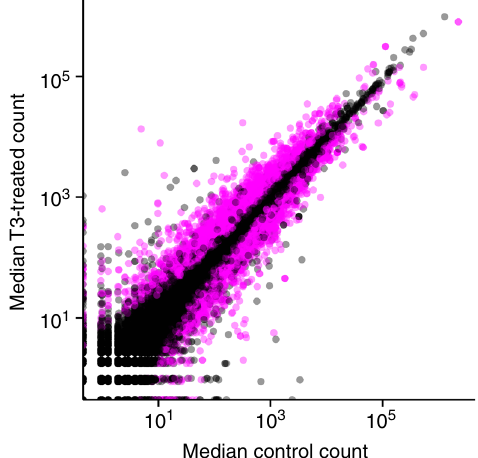
Fig. 1 Median DESeq2-normalized counts of genes detected in the back skin of premetamorphic Rana catesbeiana tadpoles treated with vehicle control or T3 for 48 h. Gene transcripts determined to be signi fi cantly differentially expressed (DESeq2 adjusted p -value < 0.05) are indicated in pink, while the remainder are semi-transparent black to convey density. Both predicted protein coding and putative lncRNA genes are depicted